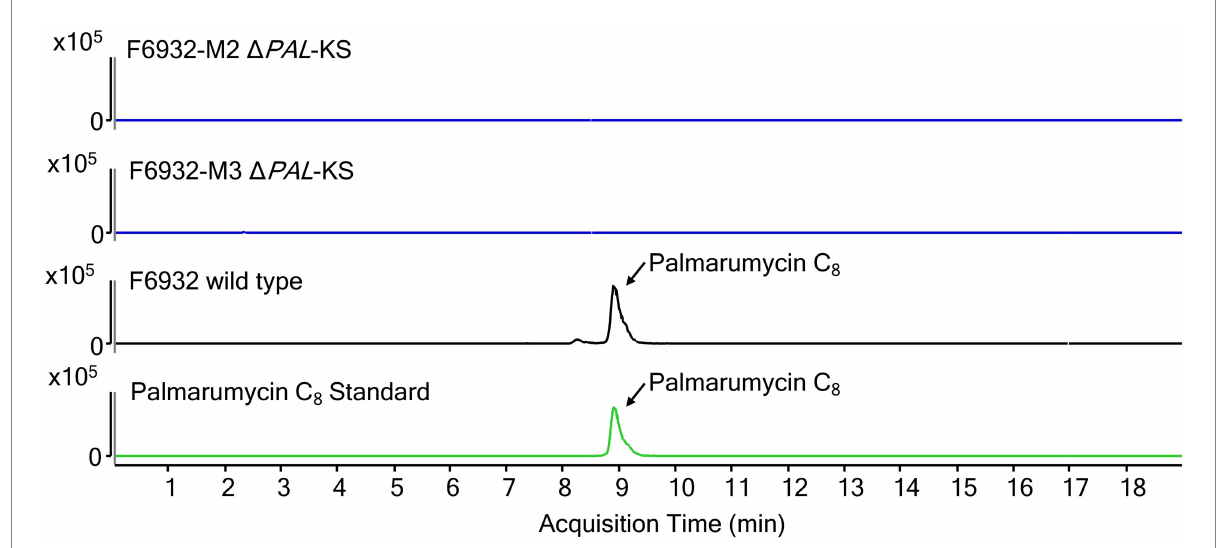
FIGURE 6 Extracted ion chromatograms (EIC) for palmarumycin C 8 of cultures extracts from wild-type Lophiotrema sp. F6932 (black line) and two arbitrarily selected Δ PAL -KS mutants (blue lines). Palmarumycin C 8 ( m/z = 385.0473 ± 10 ppm, RT 8.8